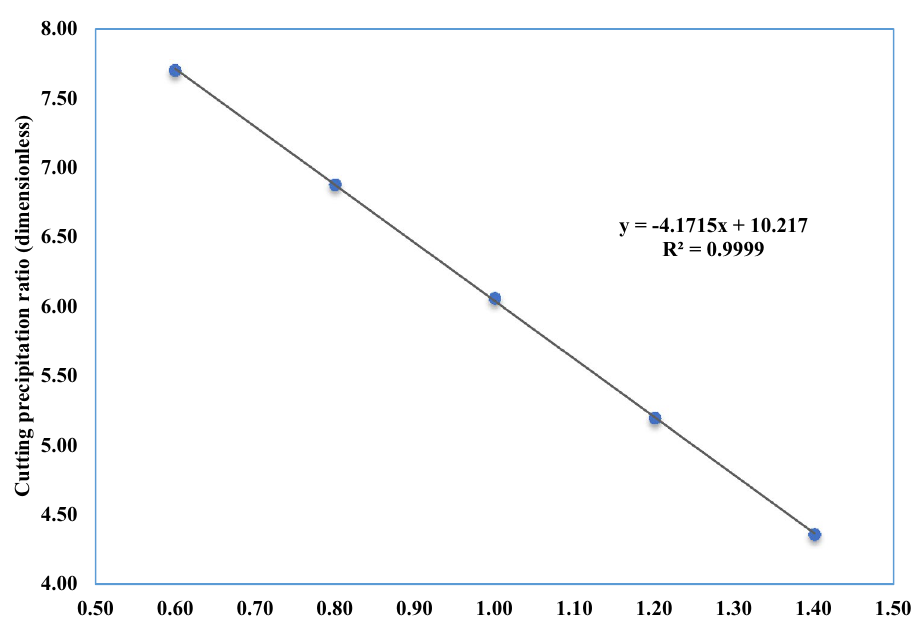
y = -4.1715x + 10.217 R² =